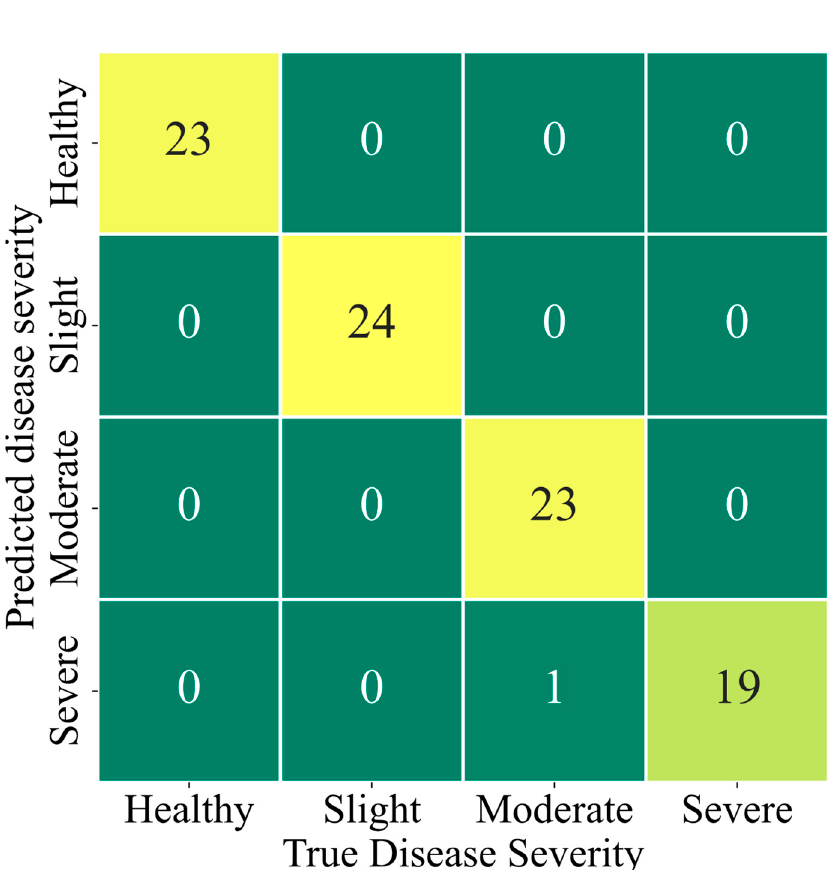
Figure 9. Confusion matrix of the classi fi cation results.